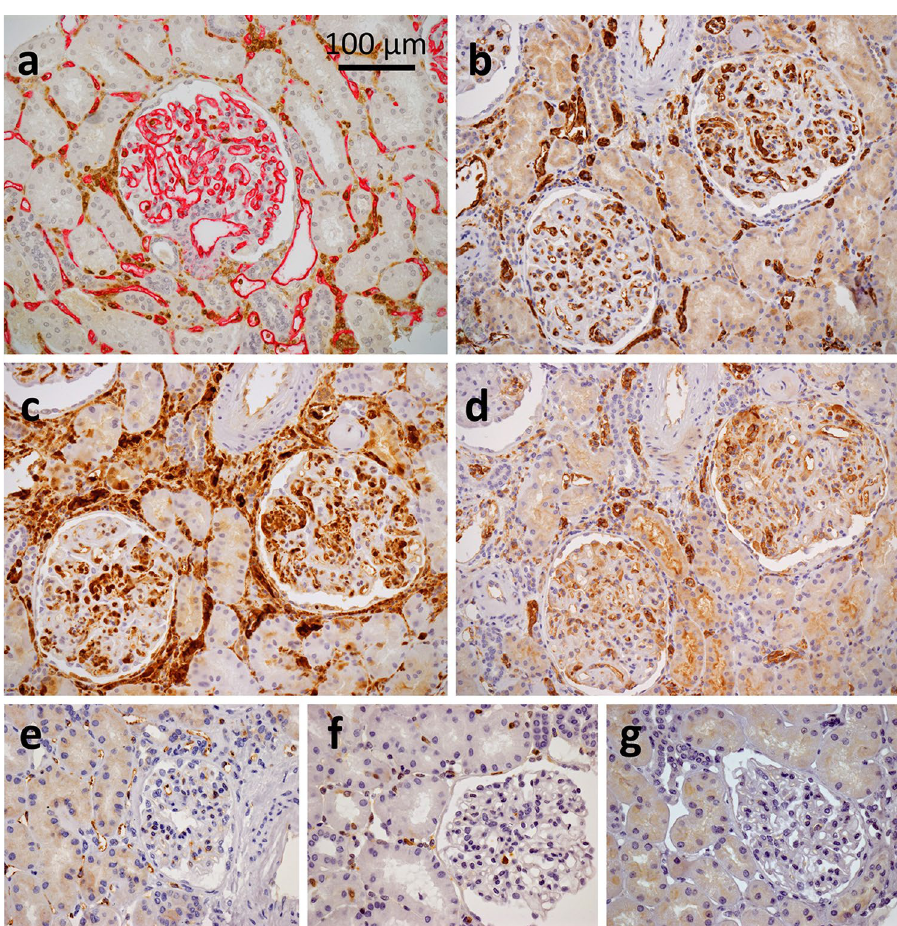
Figure 1. Description of a microcirculation staining pattern with a CD34/CORO1A control case ( a ) and illustrative examples seen in ABMR as compared to a stable graft case with WARS1 ( b , e ), TYMP ( c , f ) and GBP1 ( d , g ), original magnification × 200 ( a – d ) and × 400 ( e – g ). ( a ) The CD34 highlights endothelial cells of glomeruli and peritubular capillaries, i.e. of the microcirculation, in magenta, while CORO1A acts as a pan- leukocyte marker and highlights inflammatory cells in brown, both in the microcirculation and the interstitium. Note the similarity of the expression pattern with a strong and diffuse microcirculation staining, and to a lesser extent in inflammatory cells, obtained with WARS1 ( b ) and GBP1 ( d ). TYMP ( c ) mainly shows a diffuse and strong staining of inflammatory cells, both in the microcirculation and the interstitium, but also a moderate staining of endothelial cells. ( e ): A mild but diffuse staining of endothelial cells is observed in a stable graft case with WARS1. ( f ): In a stable case, TYMP is strongly expressed on a few inflammatory cells, wherever they are, without significant endothelial staining. ( g ): No significant staining of GBP1 in a stable graft case. Abbreviations: ABMR, antibody-mediated rejection; WARS1, tryptophan–tRNA ligase, cytoplasmic; TYMP, thymidine phosphorylase; GBP1, guanylate-binding protein